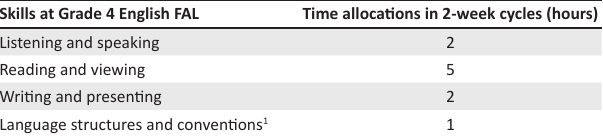
TABLE 2: Time and skill allocations for Grade 4 English First Additional Language Curriculum. Skills at Grade 4 English